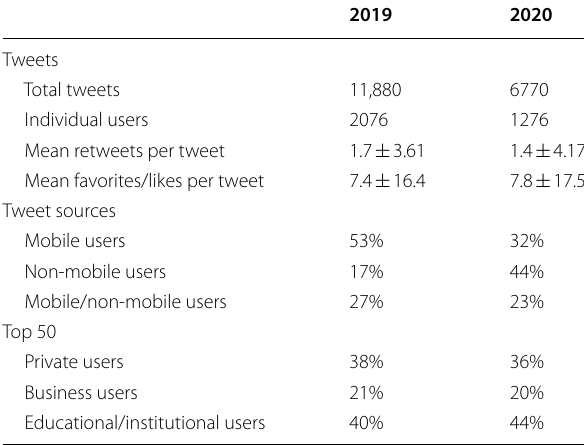
Table 1 Overview of the Twitter activity at the in-person